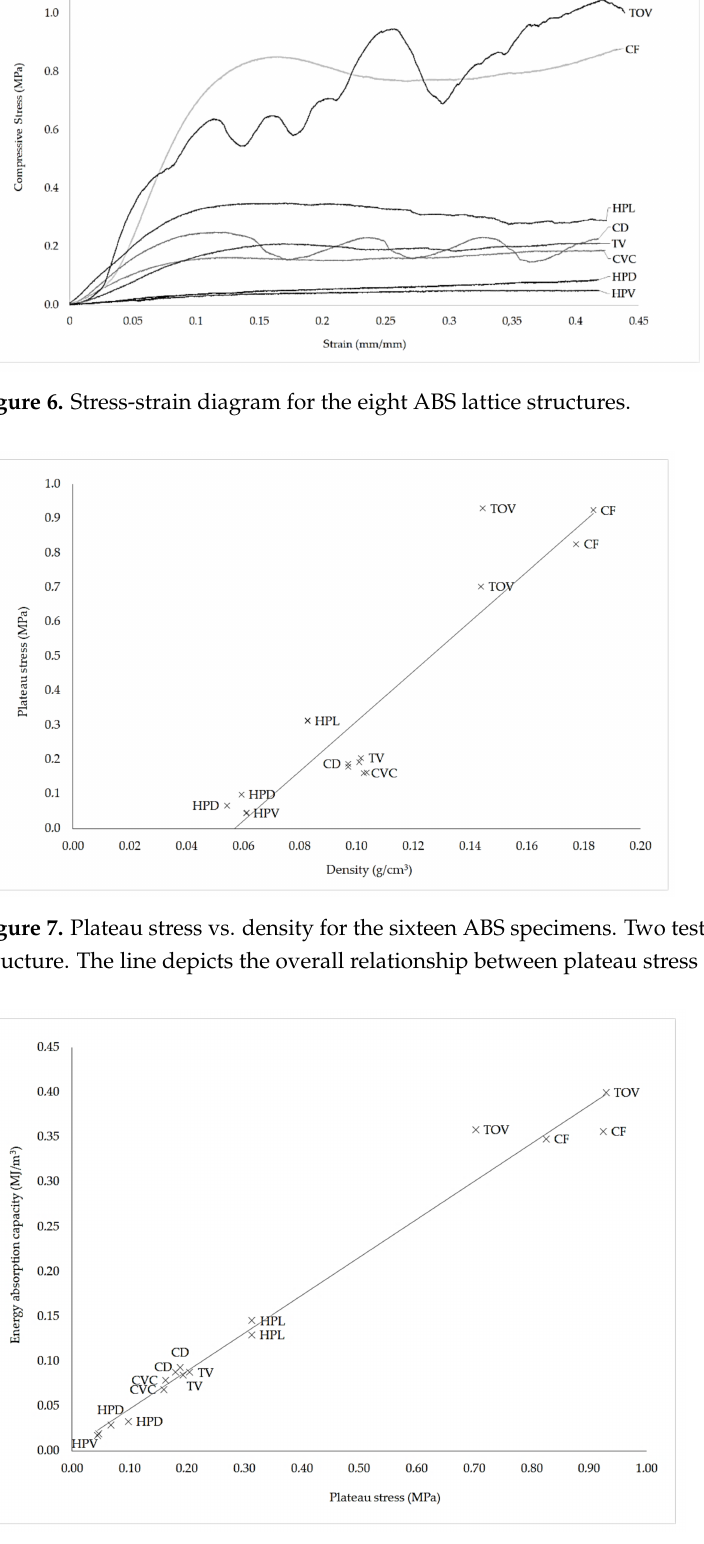
Figure 8. Energy absorption capacity vs. plateau stress for the sixteen ABS specimens. Two tests were run for each lattice